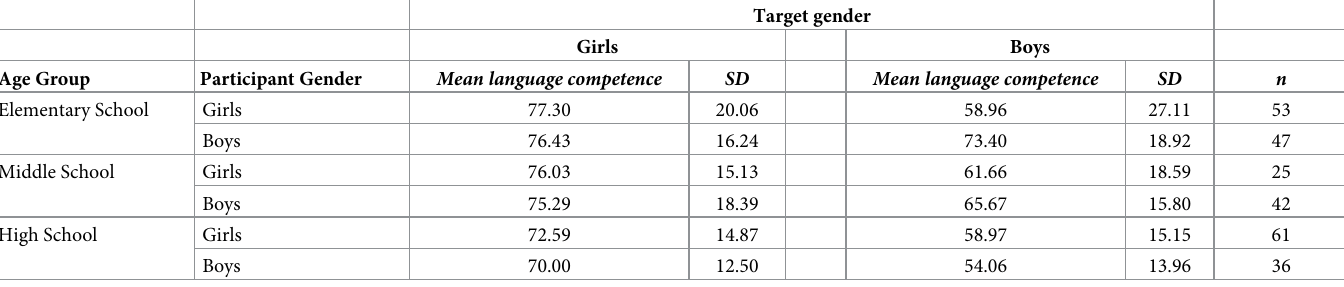
Table 5. Language explicit belief scores by age group, participant gender and target